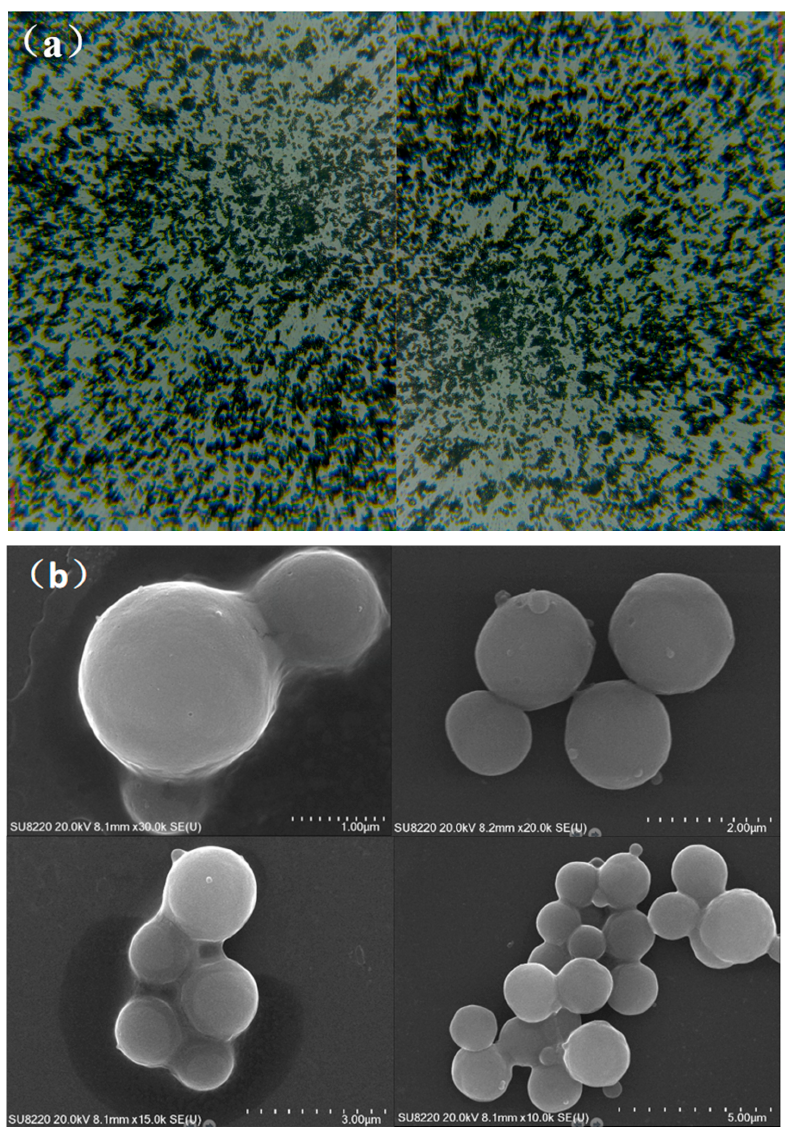
Figure 5. ( a ) Optical micrographs of the microPCMs, ( b ) SEM micrographs of the microPCMs.